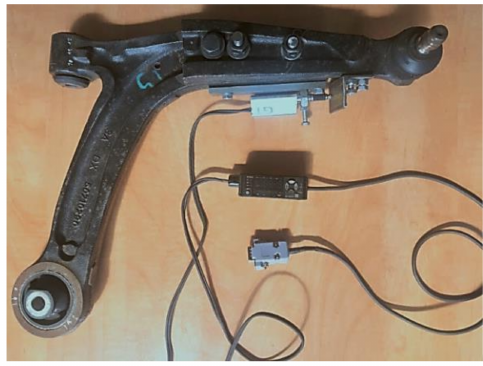
Figure 6. View of the measuring arm.